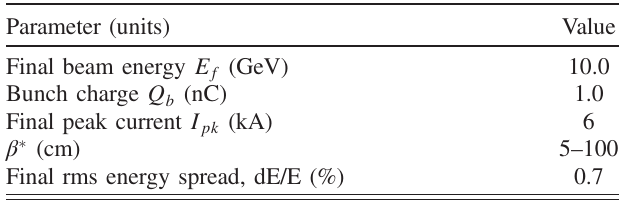
TABLE VII. Single-bunch, positron mode parameters.